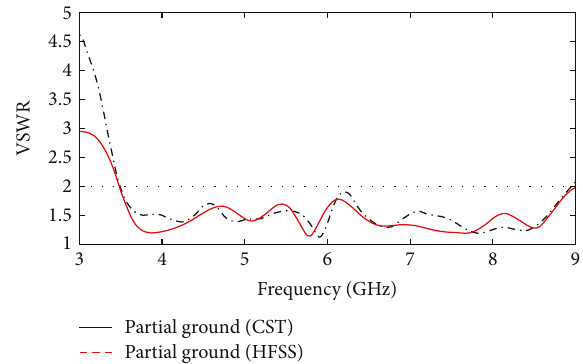
Figure 10: VSWR comparison between HFSS and CST for the array antennas with partial ground plane.